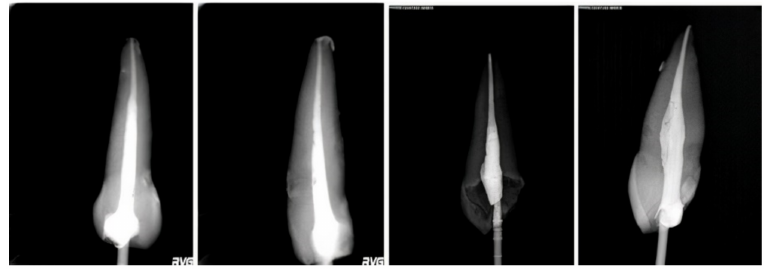
Figure 1. Rx GuttaFlow, Rx GuttaCore, Rx buccal, Rx mesial respectively.